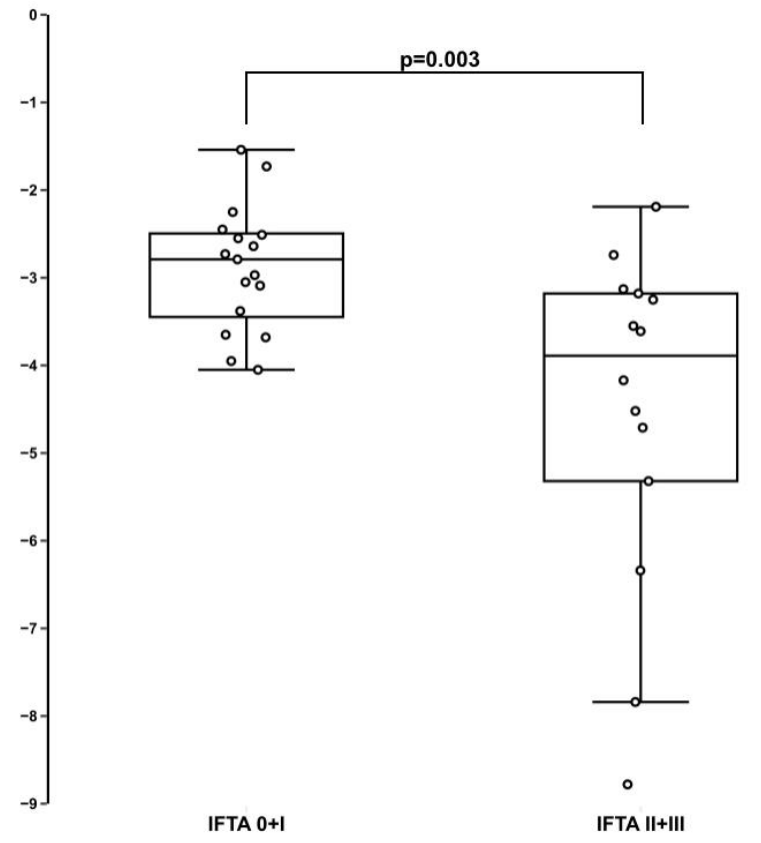
Figure 1. The relative expression levels of miR-21 in the IFTA 0 + I group compared to the IFTA II + III group. Small circle represents a single data point. group. Small circle represents a single data